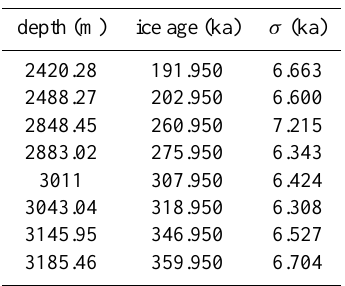
Table 5. Orbital ages from air content for Vostok, deduced from Lipenkov et al.